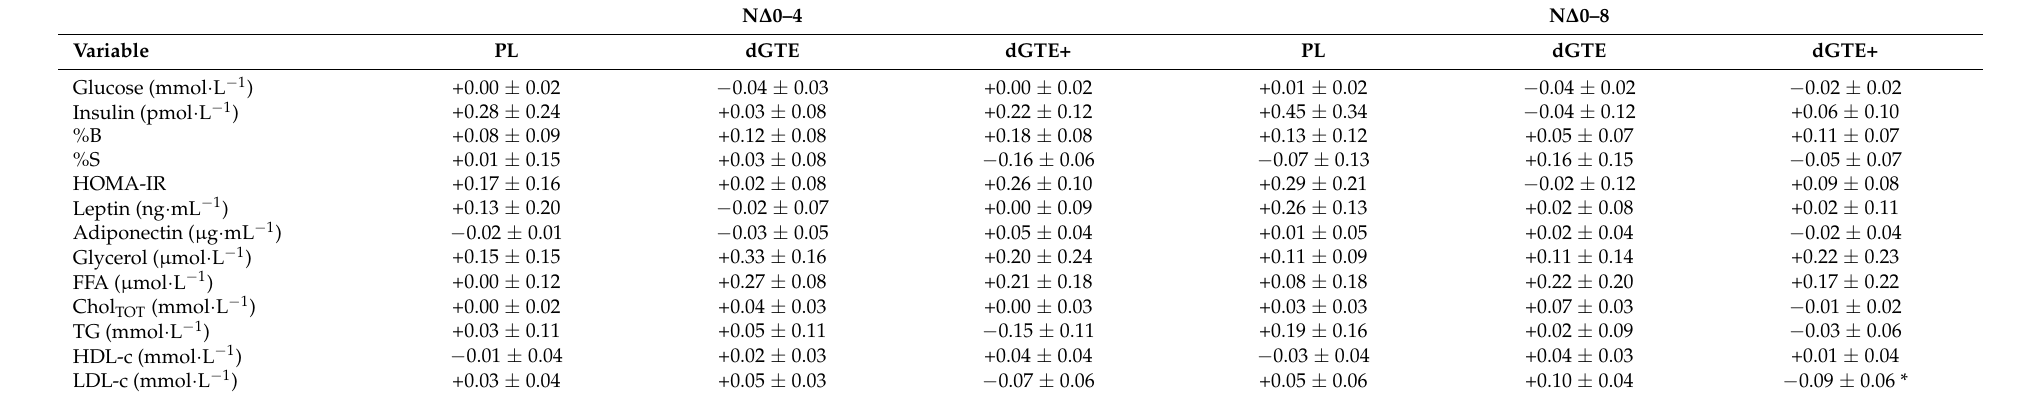
Table 8. Normalised mean fold change in serum cardio-metabolic markers by week 4 (N ∆ 0–4), and week 8 (N ∆